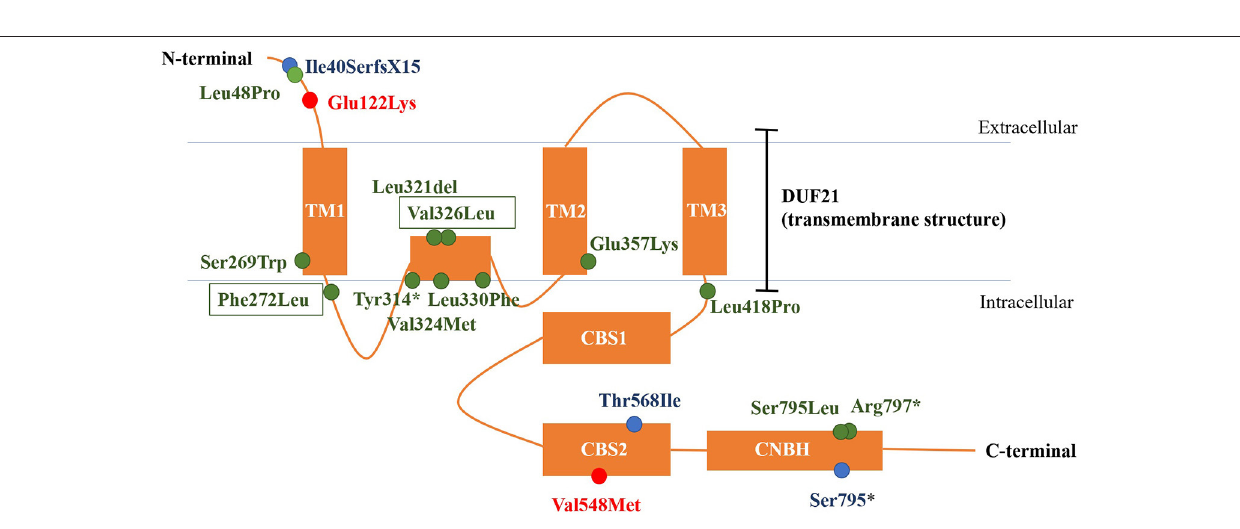
FIGURE 4 | The structure of CNNM2 and the sites of variations. Blue, AD-inherited simple hypomagnesemia; red, AR-inherited hypomagnesemia with epilepsy and ID/DD; green: AD-inherited hypomagnesemia with epilepsy and ID/DD; black box, our cases. AD, autosomal dominant; AR, autosomal recessive; ID/DD, intellectual disability/developmental